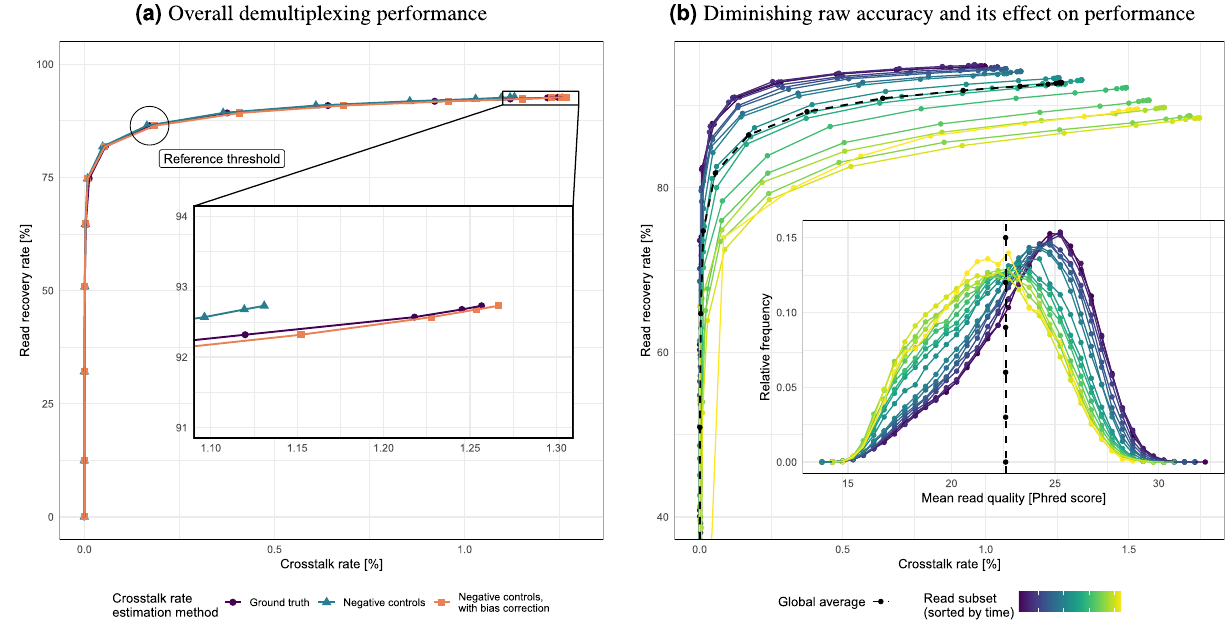
Figure 4. Demultiplexing performance of NS-watermark barcodes. ( a ) A variable threshold tunes the trade- off between the read recovery and crosstalk rates. An arbitrary threshold corresponding to 86.4% recovery and 0.17% crosstalk is highlighted for the purposes of discussion. (a-inset) Crosstalk estimated based on the set of 256 negative controls (teal) slightly underestimates the crosstalk rate based on ground truth (purple), but this bias can be approximately corrected (orange). ( b ) Reads are divided in subsets of 100,000 (sorted by time) to show that mean raw read quality diminishes as sequencing progresses (0–14.5 h). Thus, demultiplexing of young (purple) or old (yellow) subsets performs better or worse, respectively, than average (dashed,